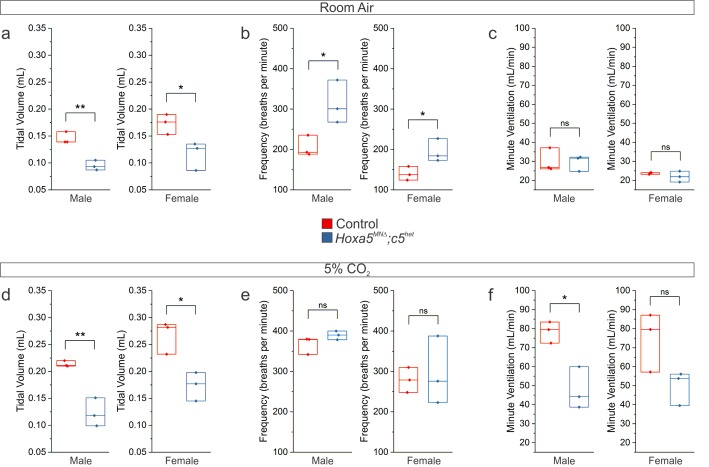
Respiratory insufficiency in both female and male Hoxa5MNΔ; c5het mice.(a-c) Raw plethysmography data in room air show decreased tidal volume and a compensatory increase in frequency in adult (P80) male and female Hoxa5MNΔ; c5het mice. (d–f) Raw plethysmography data during a 5% CO2 hypercapnic challenge show a blunted increase in tidal volume in adult (P80) male and female Hoxa5MNΔ; c5het mice, resulting in an overall decrease in ventilation.